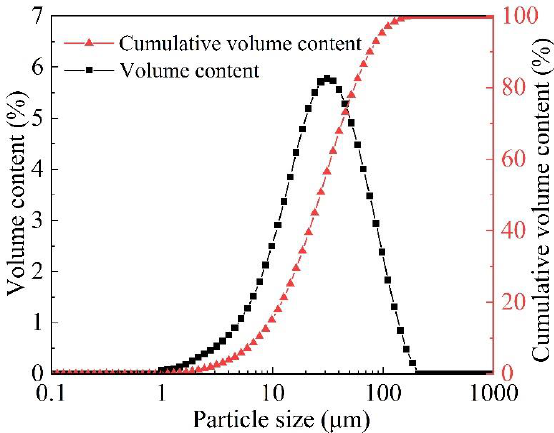
Figure 1. Particle size distribution of sericite.